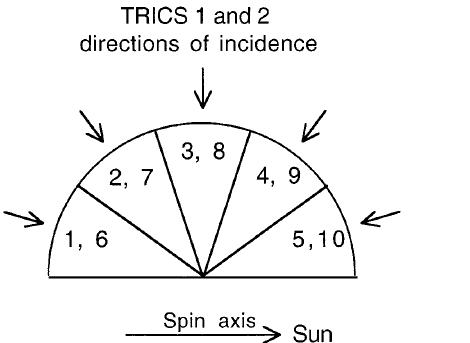
Fig. 6. Calibrated relative transmission of the TRICS detectors as a function of incidence angle with respect to the satellite